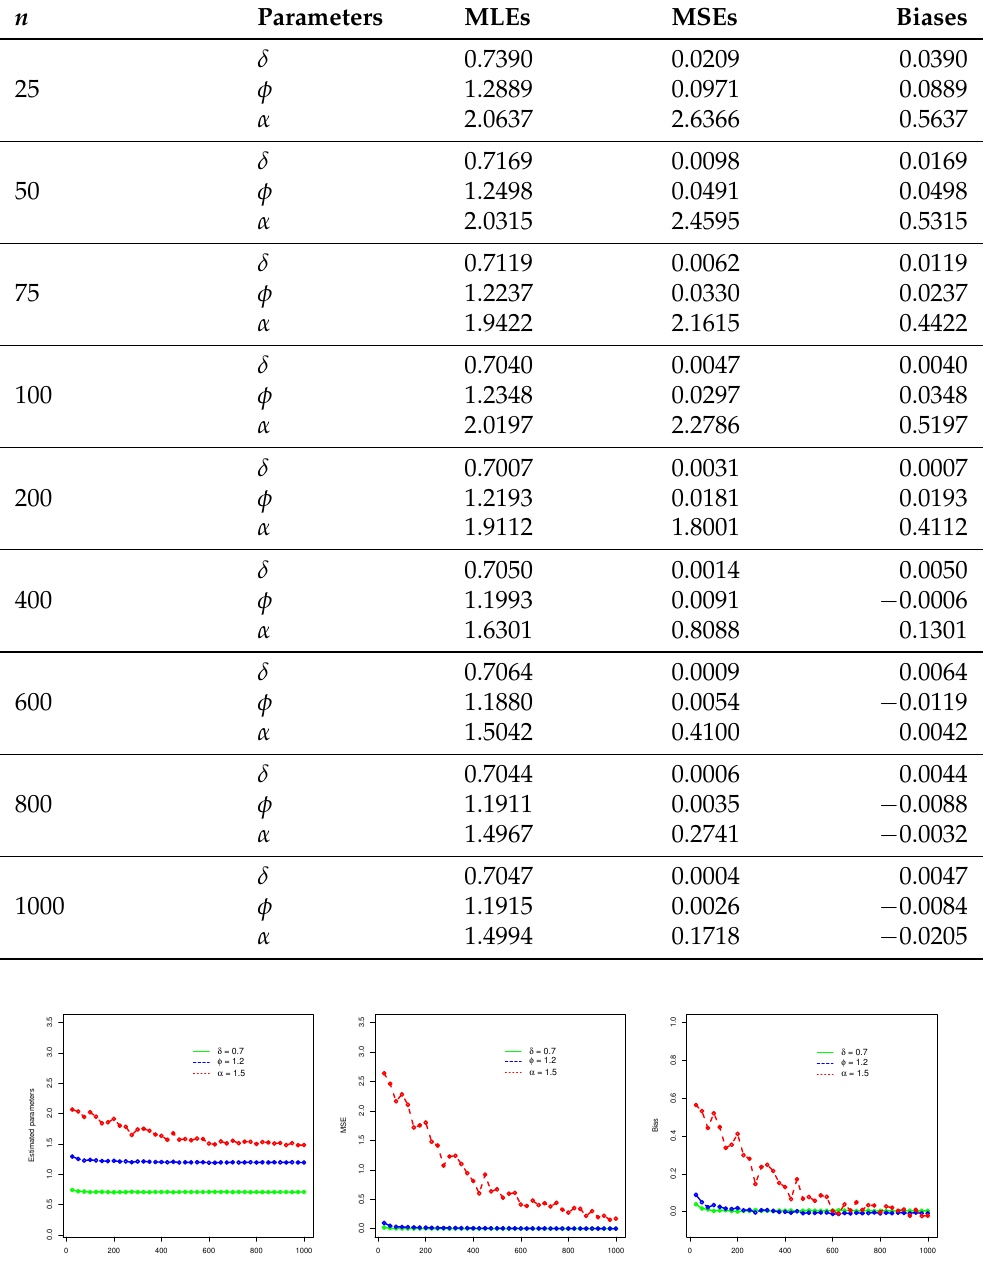
Table 3. The numerical illustration of the SS of the NACos-Weibull distribution for δ = 0.7, φ = 1.2, and α = 1.5.